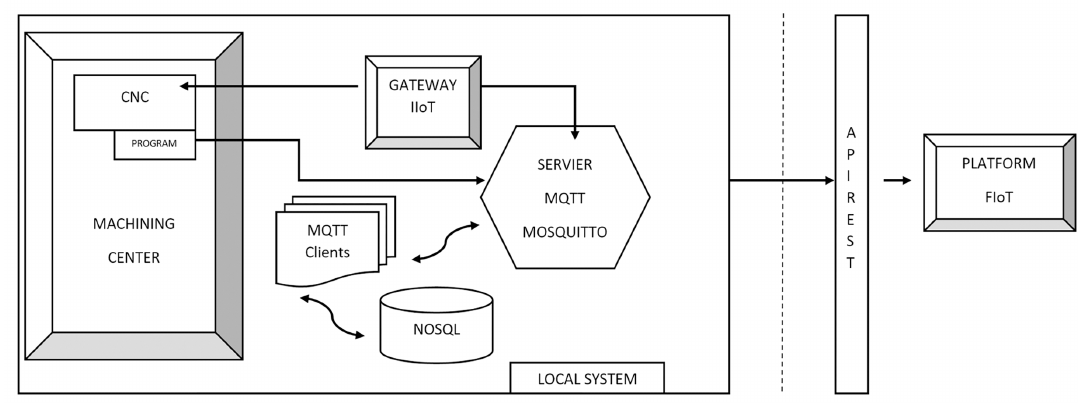
Figure 1. Outline of the design of the IoT solution. This schematic diagram shows the operation of the IoT solution. Note that only read operations are performed, so the process will never alter machine